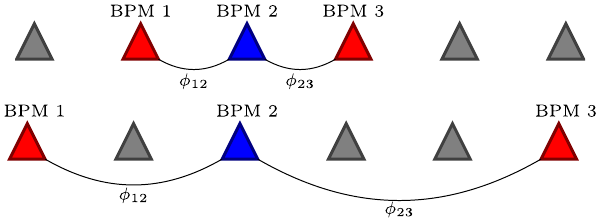
FIG. 1. TOP: the 3 BPM method takes only adjacent BPMs. The blue BPM is the one whose β function is being determined. BOTTOM: The N-BPM method allows to skip BPMs in order to use a bigger amount of data to increase statistics and to avoid unsuitable phase